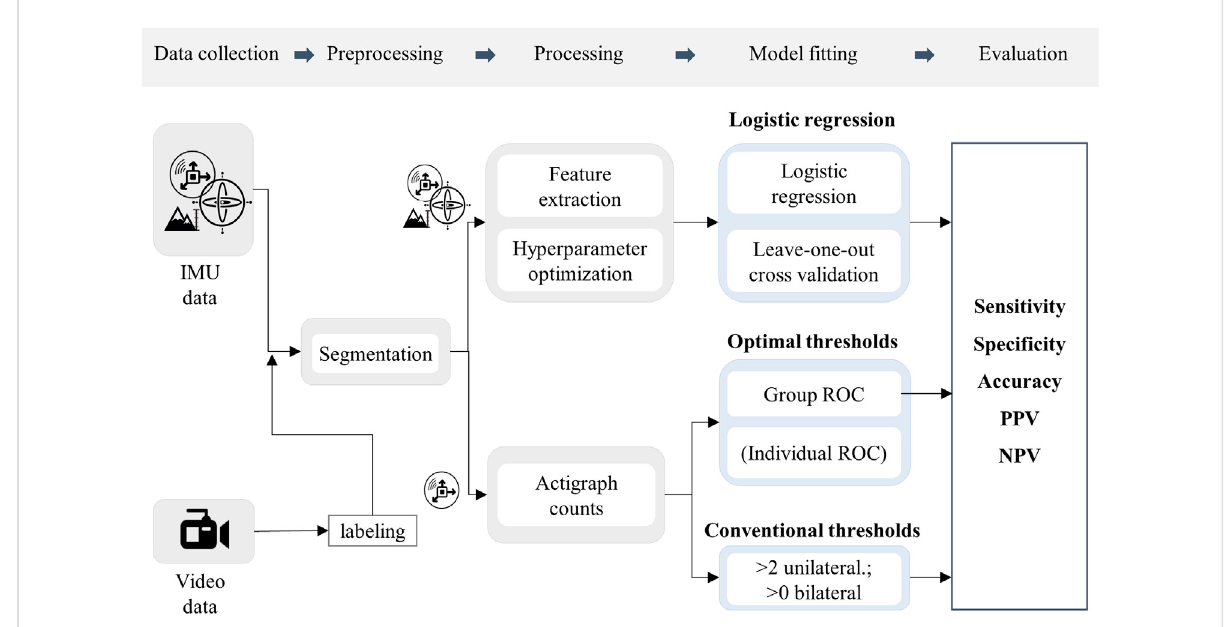
FIGURE 1 Flow chart of the methodological procedure. Icons represent the sensor modalities, accelerometer, gyroscope, and